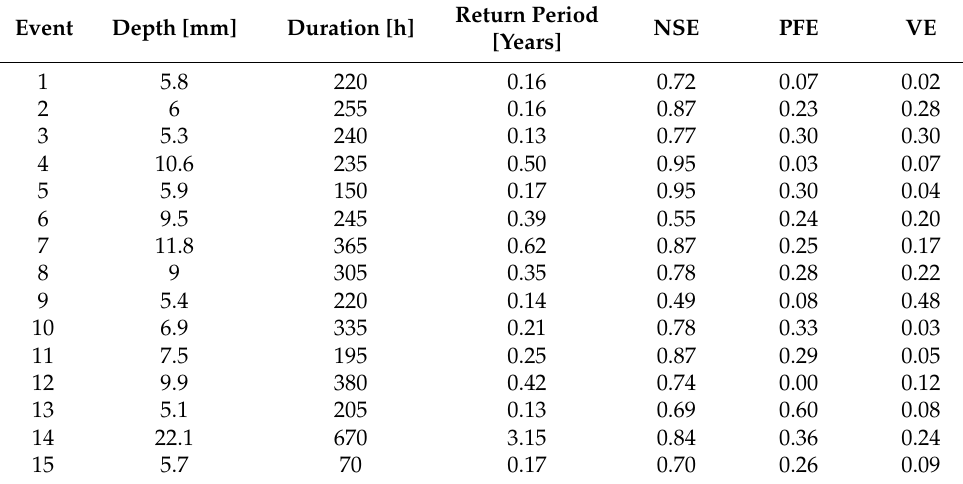
Table 2. Rain characteristics and goodness-of-fit